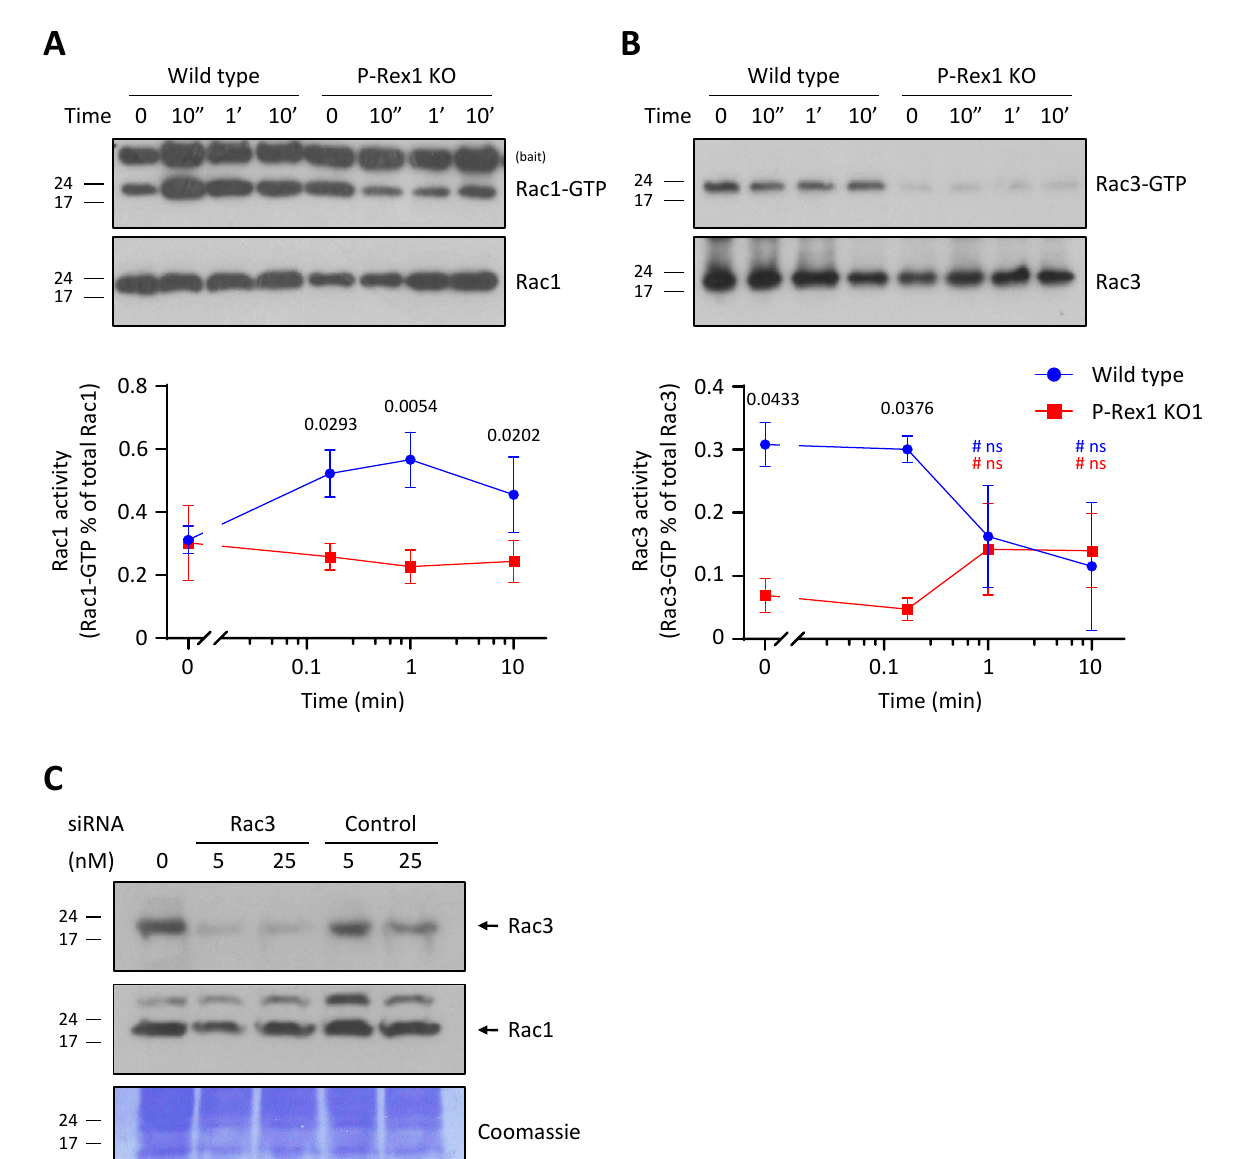
Figure 2. P-Rex1 deficiency reduces the S1P-stimulated activation of Rac1 and basal Rac3 activity in PC12-S1PR1 cells. ( A ) P-Rex1 is required for the S1P-stimulated activation of Rac1 in PC12-S1PR1 cells. Wild-type and P-Rex1-deficient PC12-S1PR1 cells were serum-starved overnight and stimulated with 5 nM S1P for the indicated periods of time at 37 ◦ C prior to cell lysis and isolation of active, GTP-bound Rac by Pak-CRIB pulldown assay. Top panels are representative Western blots showing the level of active, GTP-loaded Rac1 compared to total Rac1 in 1% of the cell lysate, processed on the same film. Bottom panel shows the quantification by densitometric analysis. Data are from six independent experiments and are presented as the mean ± SEM. Statistical analysis involved two-way ANOVA with Sidak’s multiple comparisons test. ( B ) P-Rex1 is required for basal Rac3 activity in PC12-S1PR1 cells. The same cell lysates as in ( A ) were analysed for Rac3 activity. Top panels are representative Western blots showing active, GTP-loaded Rac3 from Pak-CRIB pulldown assay compared to total Rac3 level in 1% of the cell lysate, processed on the same film. Bottom panels show quantification by densitometric analysis. Data are from three independent experiments and are presented as the mean ± SEM. Statistical analysis involved two-way ANOVA with Sidak’s multiple comparisons test; ‘# ns’ denotes no significant differences between S1P-stimulated and control conditions within each genotype. ( C ) Rac3 antibody specificity. Wild-type PC12-S1PR1 cells were treated with the indicated doses of Rac3 siRNA or control siRNA, and total cell lysates were Western blotted for endogenous Rac1 and Rac3; Coomassie staining of the membrane was used as a loading